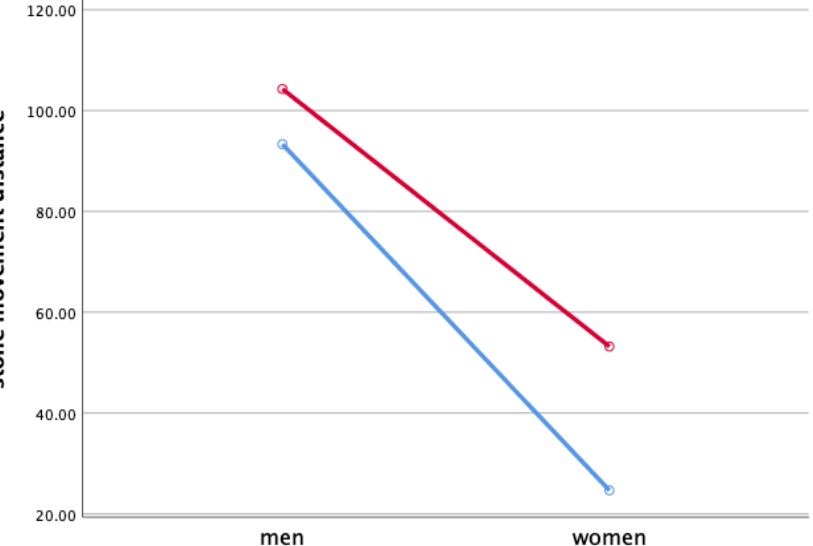
Figure 1. Stone Movement Distance When Sweeping (cm). Red line: along the axis of motion, blue line: perpendicular to the axis of motion.